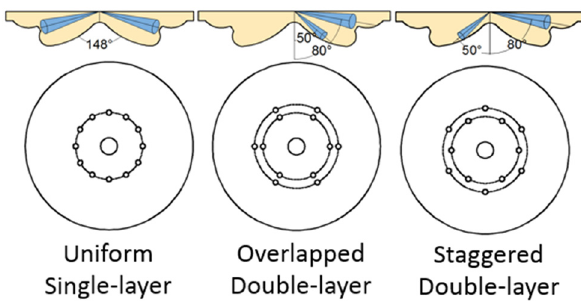
Figure 4: Di ff erent arrangement schemes of three nozzle holes based on DLSB - B.